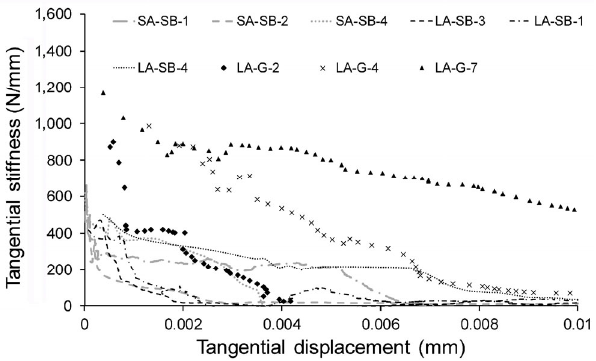
Fig. 16 Representative results of tangential stiffness against tangential displacement at the interfaces of chrome steel balls and crushed granitic granules.